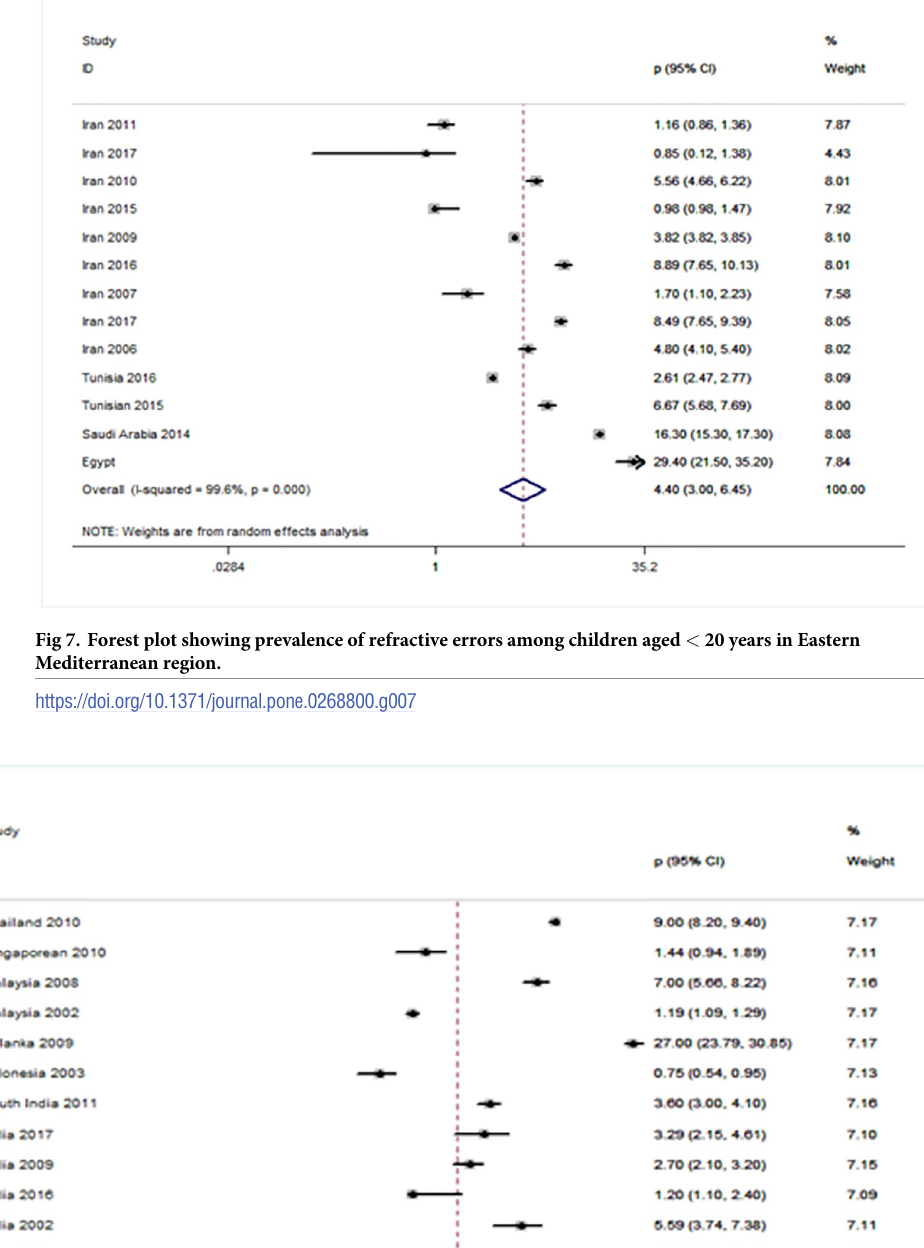
PLOS ONE | https://doi.org/10.1371/journal.pone.0268800 July 1,